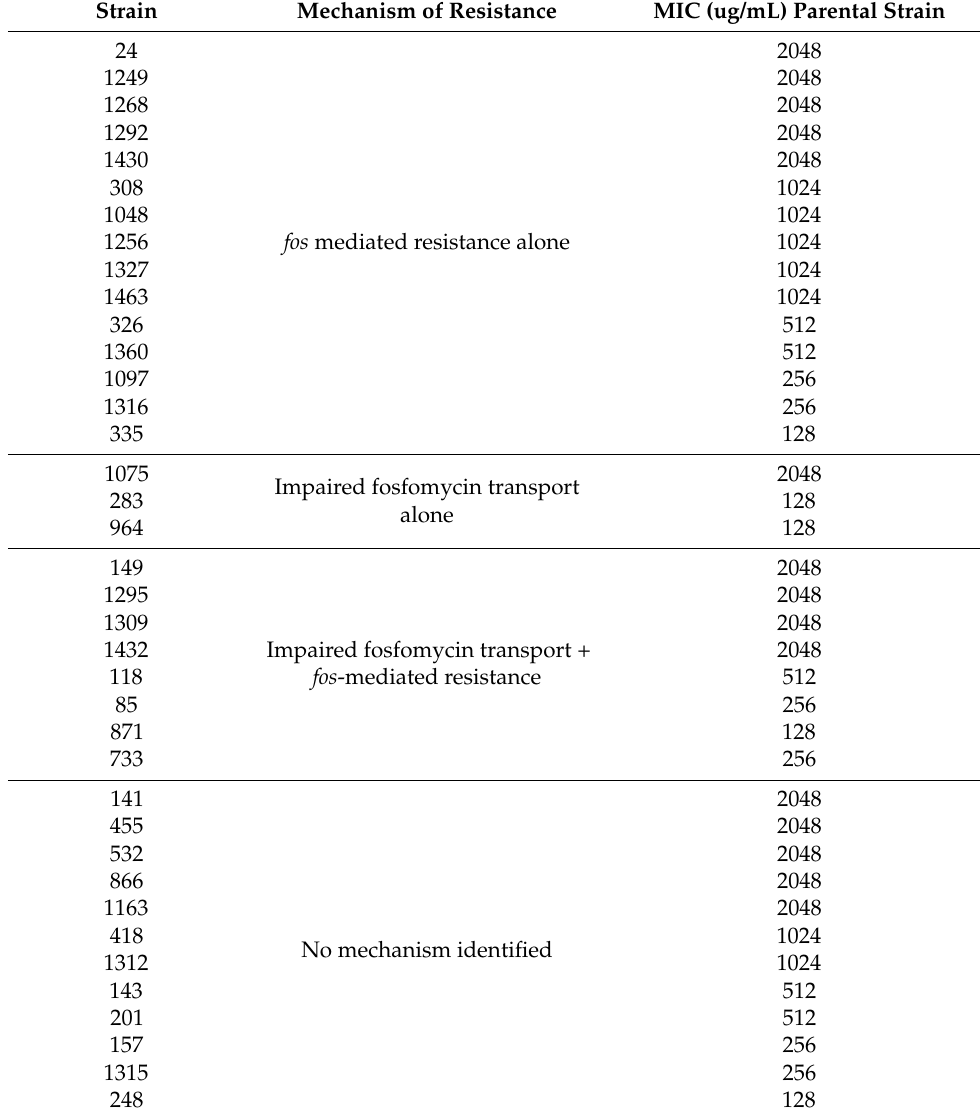
Table 1. Minimum inhibitory concentrations (MIC) of uropathogenic ESBL-producing E. coli strains and their mechanisms of fosfomycin